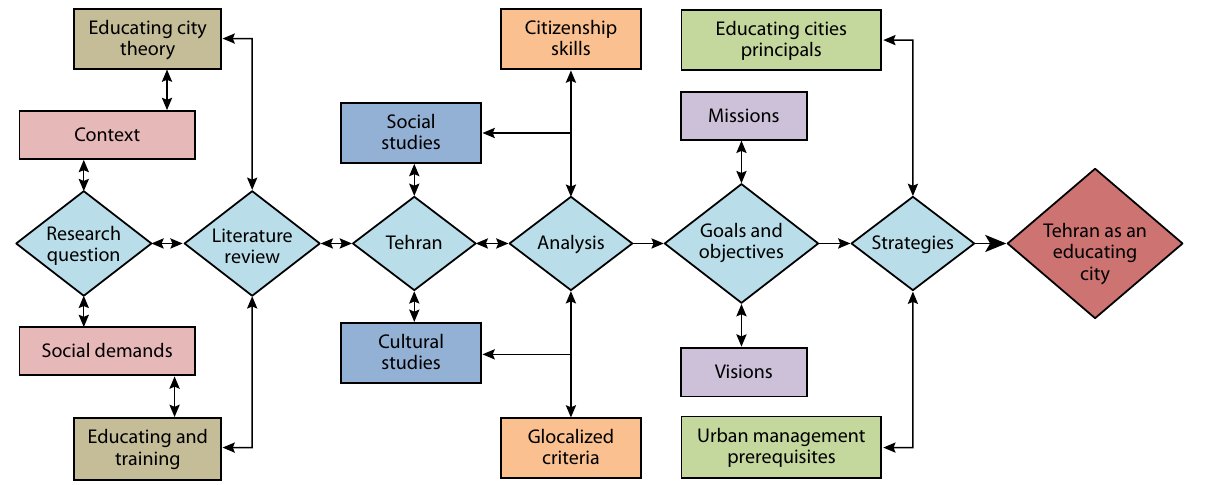
fig. 7. Implementation mechanism of the educating city theory in contemporary